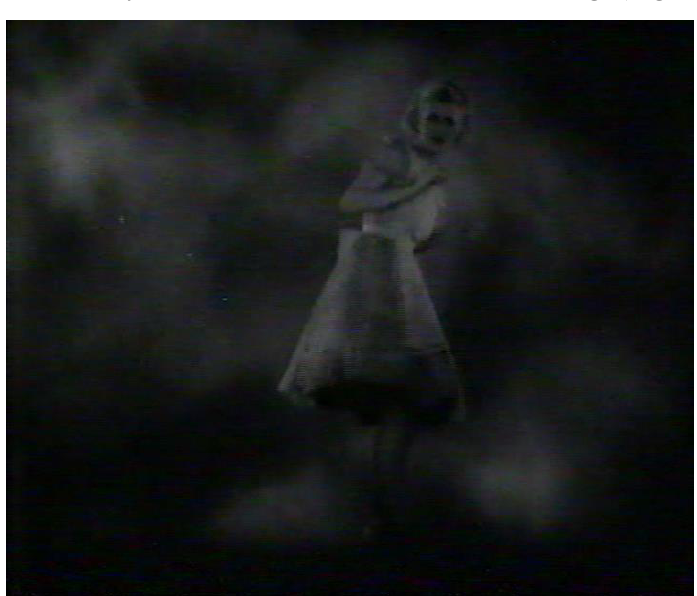
Figure 6. In Puttin’ on the Ritz , the liminal space of tragicomedy: Alice on the edge between two worlds in “Alice in Wonderland.”